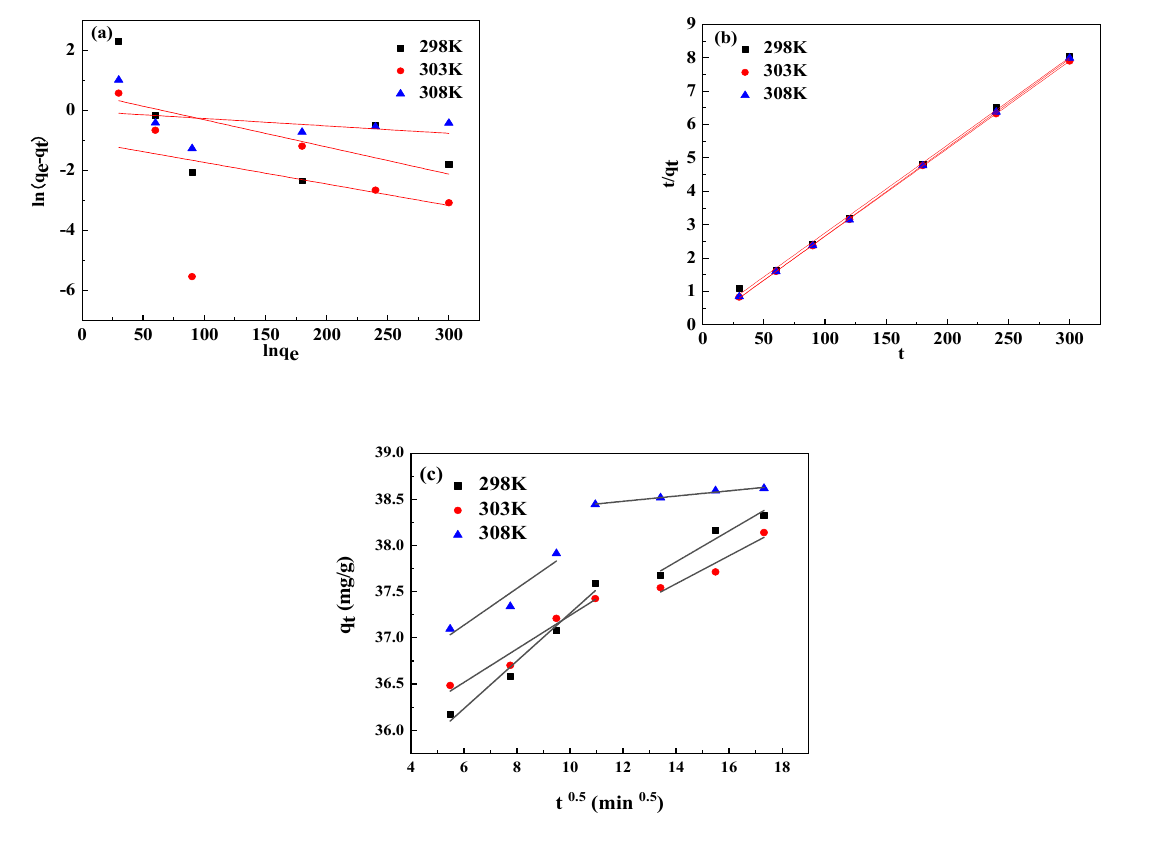
Figure 14. ( a ) Pseudo-first order and ( b )pseudo-second order and ( c ) intra-particle diffusion kinetic models of MDG on adsorption of MG solution at different temperatures. Table 3. Adsorption kinetic model parameters of Pseudo-first kinetic model pseudo-second kinetic model and intra-particle diffusion kinetic mode.